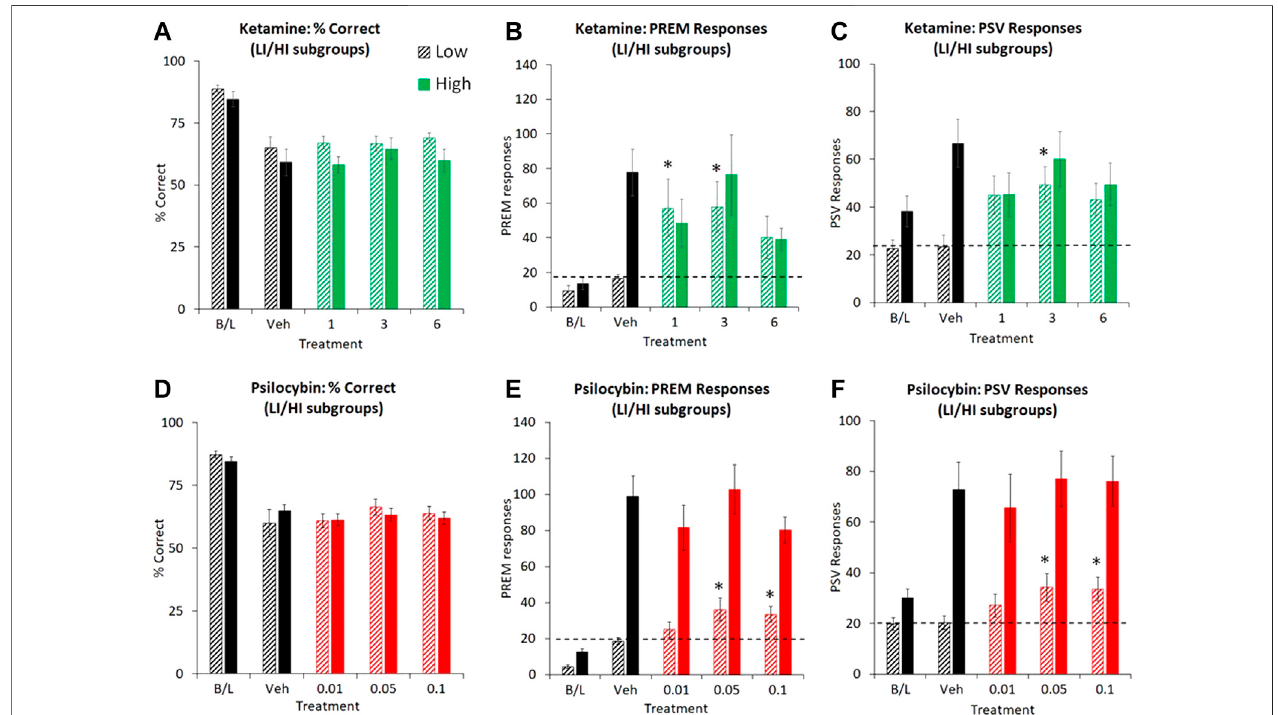
FIGURE 5 | Characterisation of ketamine (1 – 6 mg/kg IP) and psilocybin (0.01 – 0.1 mg/kg SC) on performance of rats in the 5-choice serial reaction timetask. Test conditions of 0.3 s SD, 10 s ITI, 100 trials; i.e. extended ITI. Data is presented for both drugs as % correct, (A and D) , total number of premature (PREM) responses (B andE) ,andtotalnumberofperseverative(PSV)responses (CandF) .forsubjectscharacterizedas “ lowimpulsive ” (LI)or “ highimpulsive ” (HI)performers(ketamine:N (cid:1) 8 per tertile; psilocybin: N (cid:1) 19 per tertile). The hashed line is to highlight the level of the “ low impulsive ” subgroup following vehicle pretreatment. Dizocilpine (DZP, 0.02 mg/kgSC)datawerenotincludedinthese fi guresduetomagnitudeofchangeobscuringeffectsofketamineandpsilocybin.* p < 0.05vs.vehiclecontrol,# p < 0.05 vs. all treatment groups (Dunnetts test following signi fi cant ANOVA).